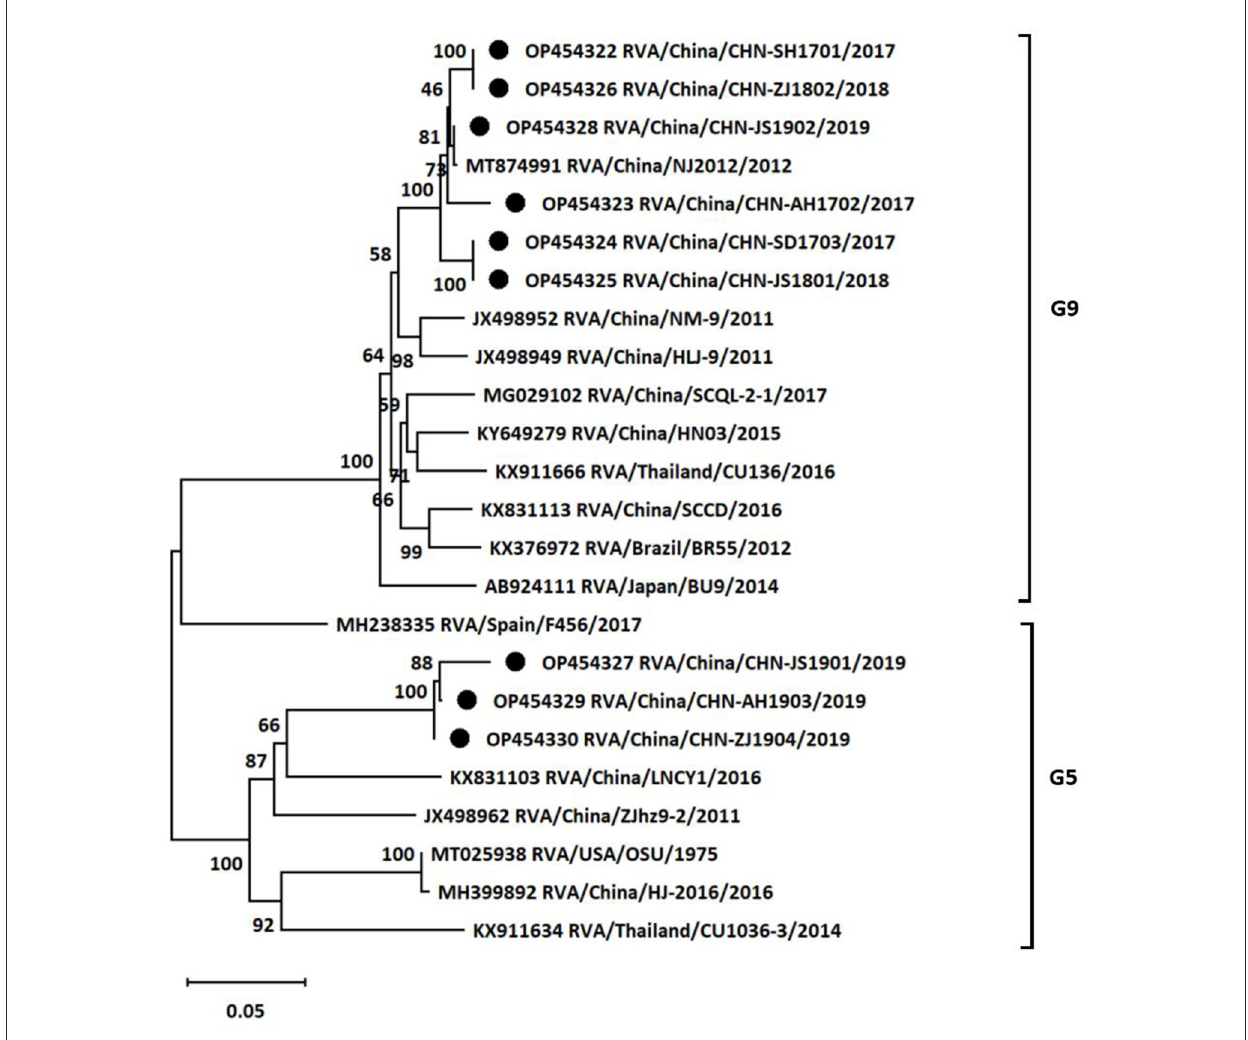
FIGURE2 Phylogenetic tree based on the nucleotide sequences of VP7 genes from different porcine rotavirus strains: phylogenetic tree was constructed by neighbor-joining (NJ) method for the VP7 sequences of different strains using MEGA11 software. Bootstrap values were calculated on 1,000 replicates. The evolutionary distances were computed using the p -distance method. Other parameters were preserved by default. The nine strains from the positive samples were labeled with black